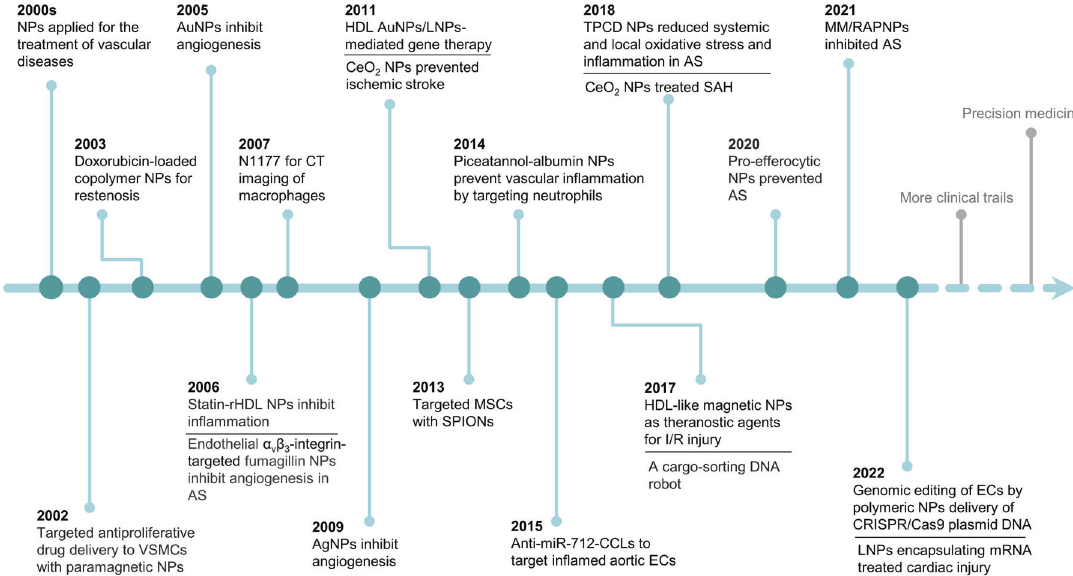
Fig. 6 Historical timeline of nanoparticles-based therapies in vascular aging-related diseases. This timeline scheme was made using the Web of Science database. Key discoveries are highlighted. NPs nanoparticles, VSMCs vascular smooth muscle cells, AuNPs gold nanoparticles, rHDL reconstituted high-density lipoprotein, AS atherosclerosis, AgNPs silver nanoparticles, HDL high-density lipoprotein, LNPs lipid nanoparticles, CeO 2 NPs cerium oxide nanoparticles, MSCs mesenchymal stem cells, SPIONs superparamagnetic iron oxide nanoparticles, ECs endothelial cells, SAH subarachnoid hemorrhage, I/R ischemia reperfusion, MM/RAPNPs macrophage membrane coating on the surface of rapamycin- loaded poly (lactic-co-glycolic acid) copolymer